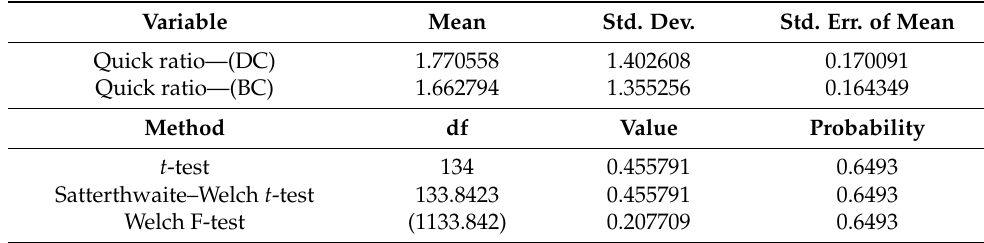
Table 6. The result of the quick ratio.